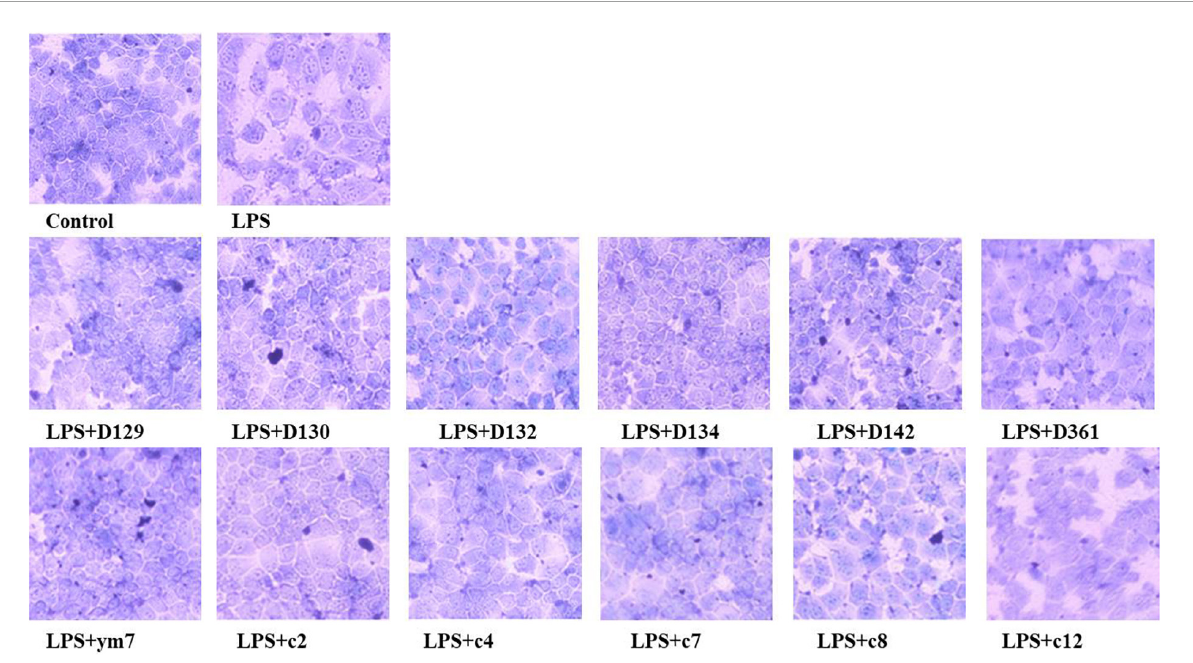
FIGURE2 The protective effect of hemp leaf extracts on the morphology of MDCK cells with LPS-induced inflammation. Data are expressed as the mean ± SD ( n = 3).